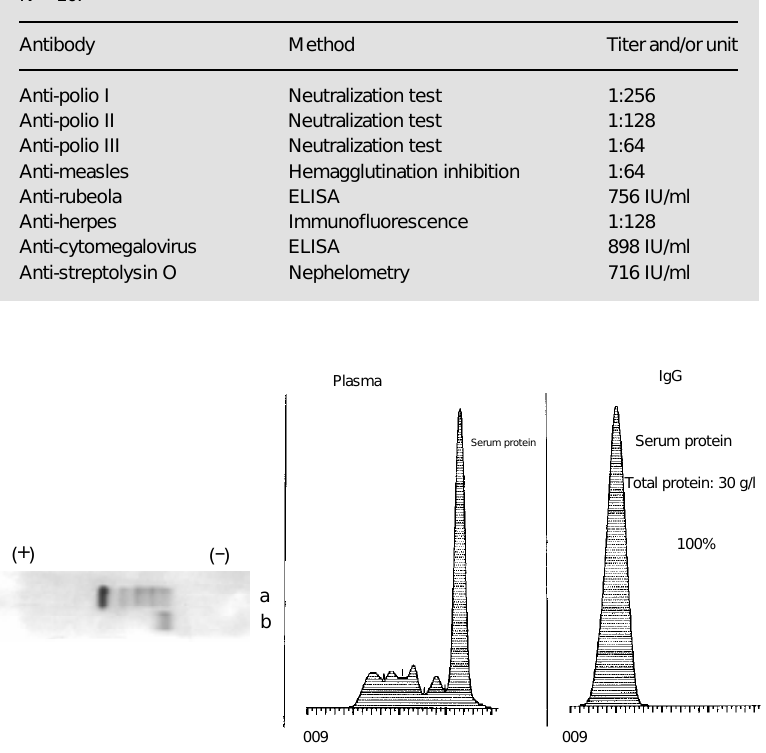
Figure 2 - Cellulose acetate electrophoresis. a , Plasma pool (25 µl of 10 g/l); b , immunoglo- bulin G (25 µl of 30 g/l). Protein was detected with Ponceau S and the data are reported as percent of total densitometer